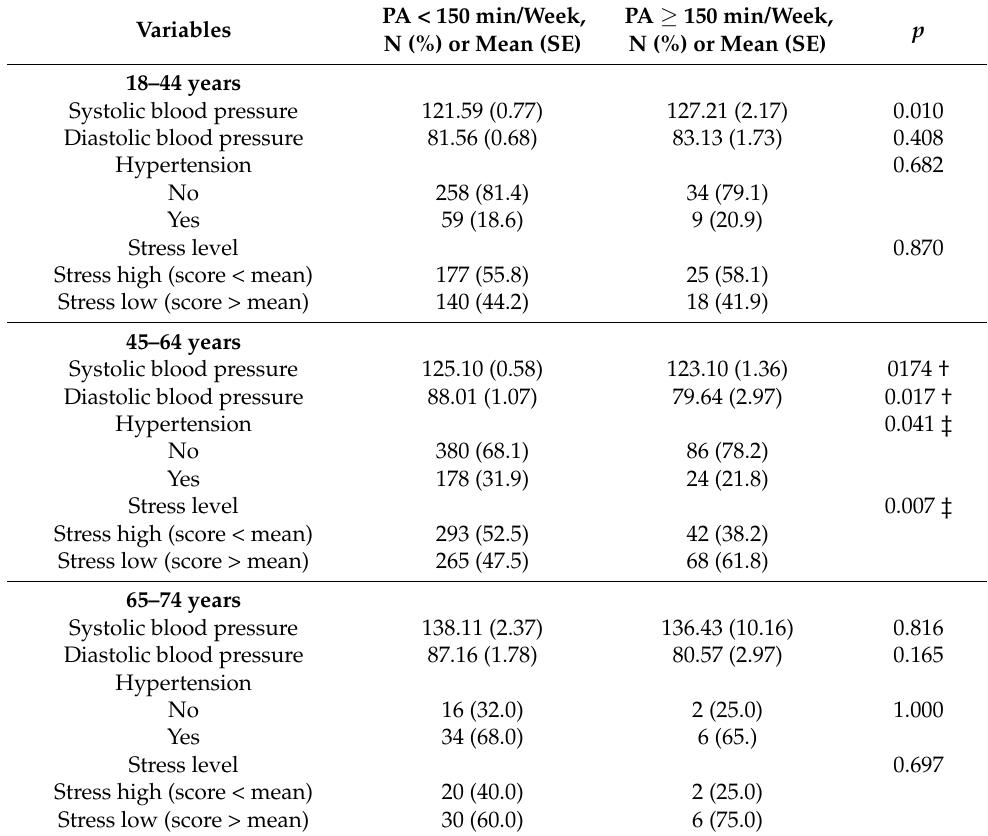
Table 2. Self-reported health characteristics in 18–74-year-old participants’ groups by physical